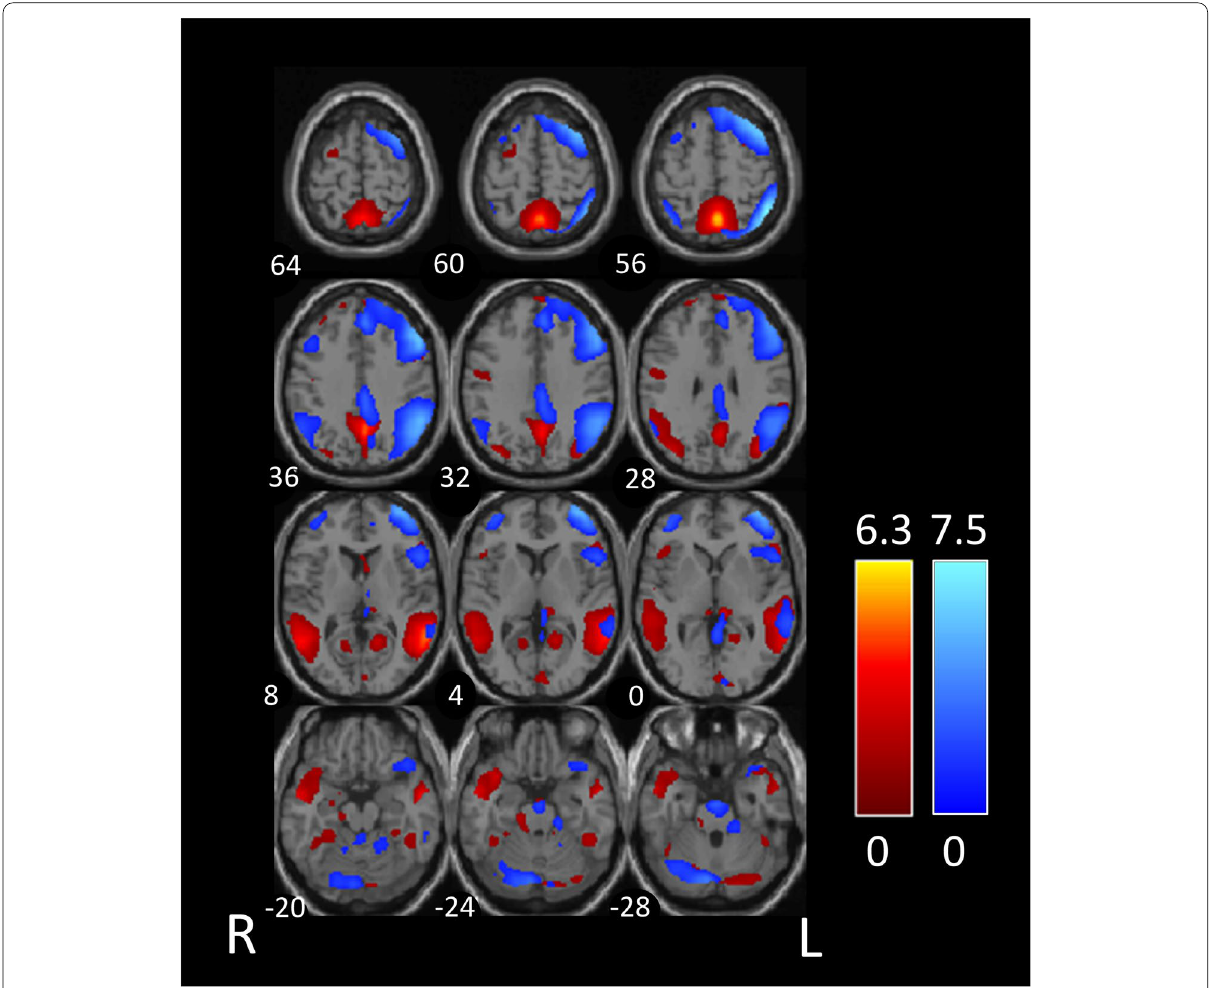
Fig. 1 In the comparison between migraine with aura patients group and healthy subjects group before visual stimulation, the default-mode network (IC3, in red) and the left dorsal attention system (IC10, in blue) showed moderate connectivity. The images were co-registered in MNI space. The number under each brain image refers to the z-coordinate in Talairach space. The coloured bars reflect the functional connectivity maps (Z scores) of each